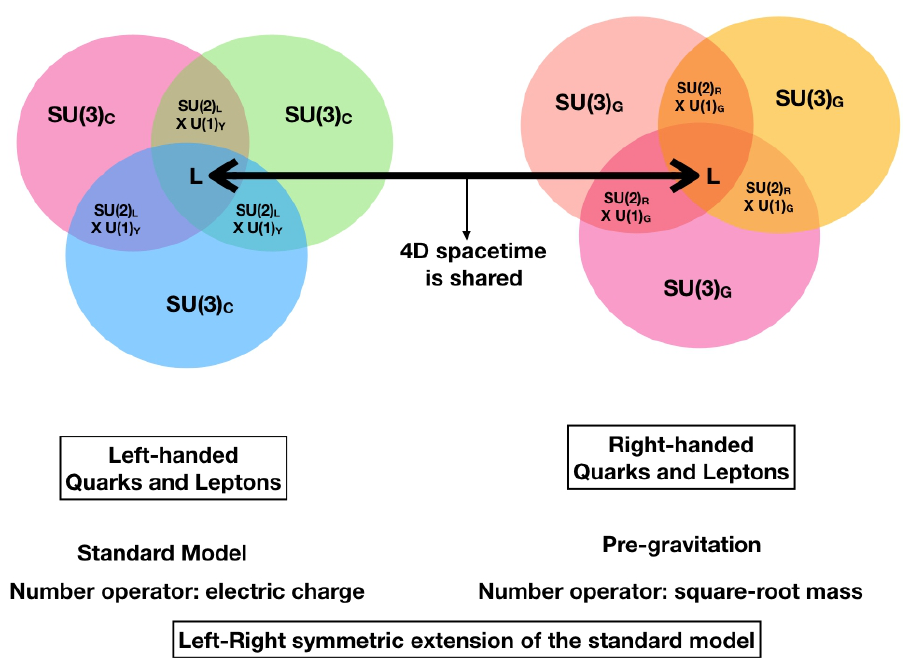
Figure 1. Unification from symmetries of E 6 . See text for